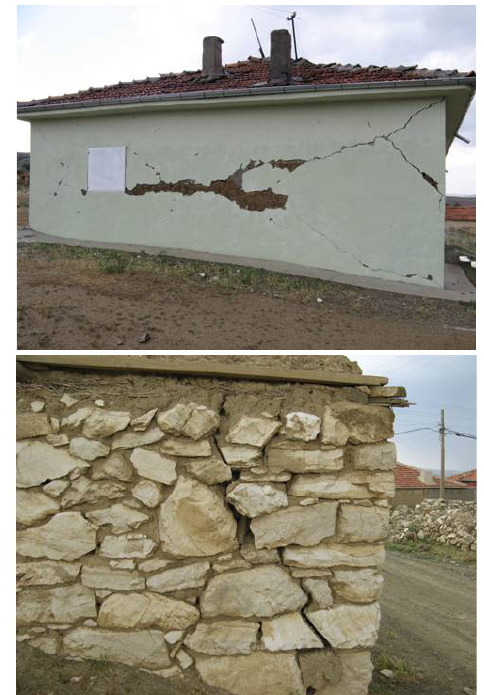
Fig. 12. Example of failure of low strength stone on a masonry building. Fig. 12 Example of failure of low strength stone on a masonry building